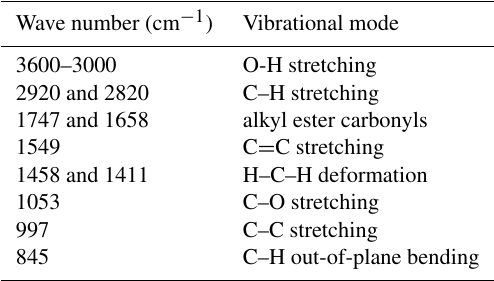
Table 1. Vibrational mode assignment for six pollen species inves- tigated in this